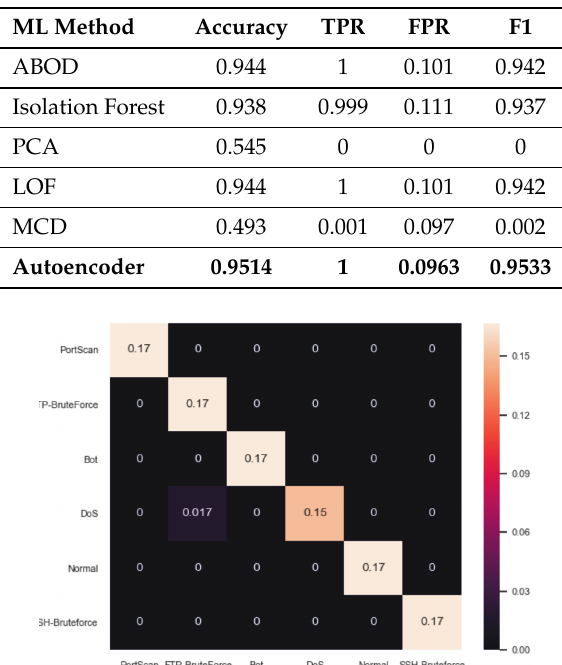
Figure 6. Confusion Matrix of IDM (Decision Tree Classifier).